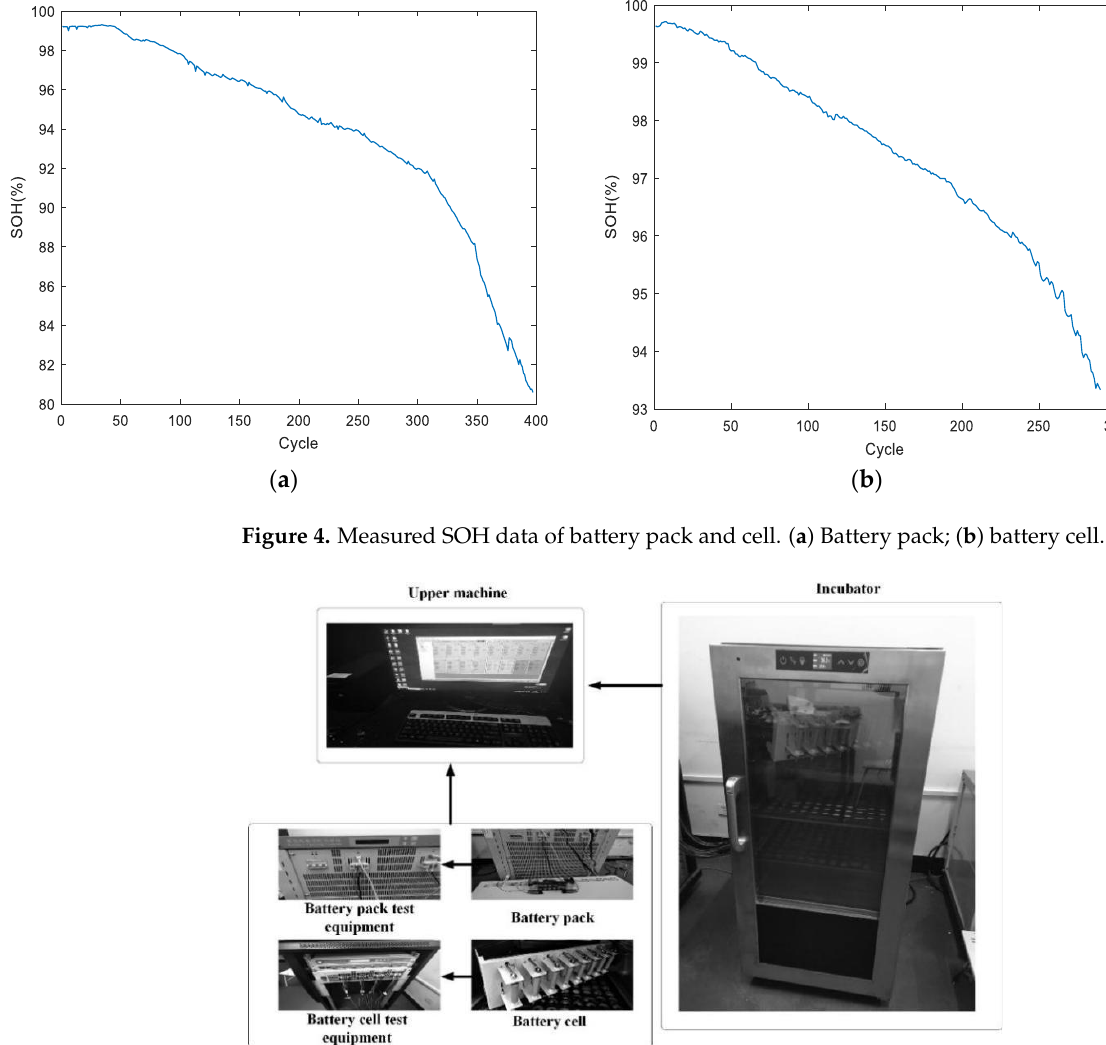
Figure 5. The efficient battery test